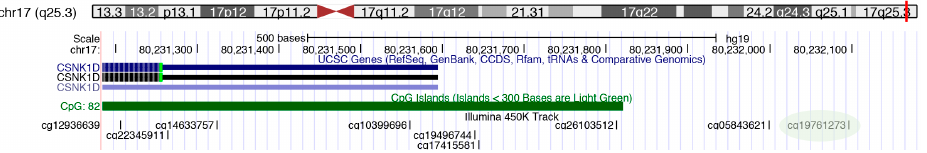
Figure 5. ( a ) A histogram of the age distribution for healthy individuals; ( b ) A histogram of the age distribution for disease individuals.